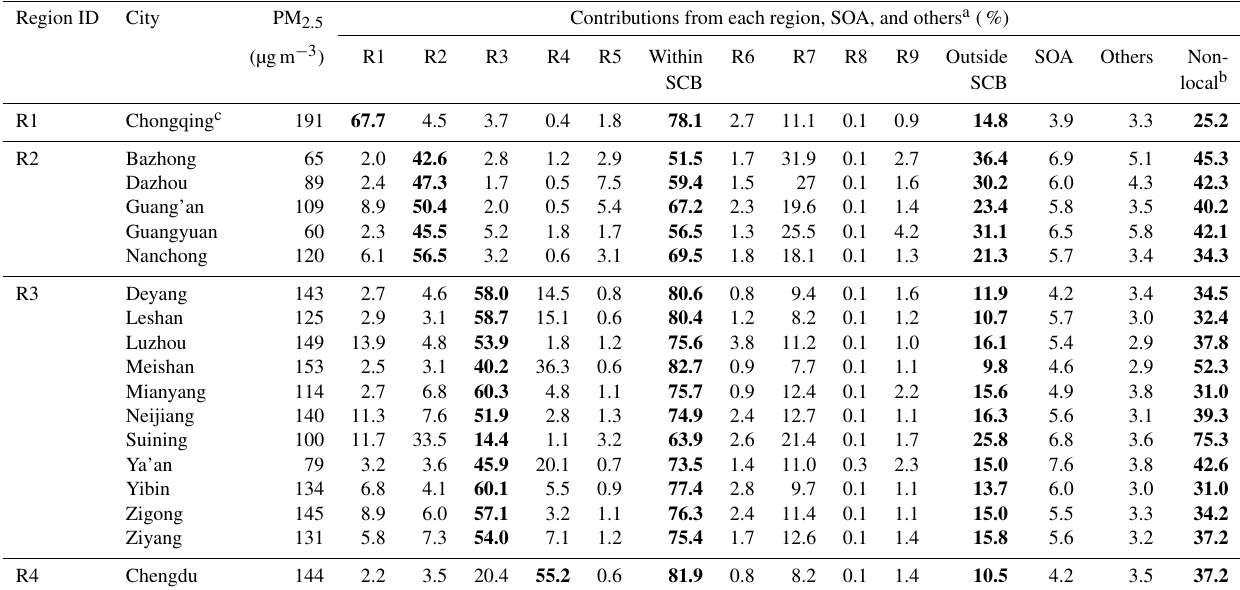
Table 1. Predicted source-region contributions to PM 2 . 5 in the 18 SCB city centers in the winter. The data in bold font show the contributions due to local emissions, emissions within SCB, or emissions outside SCB.